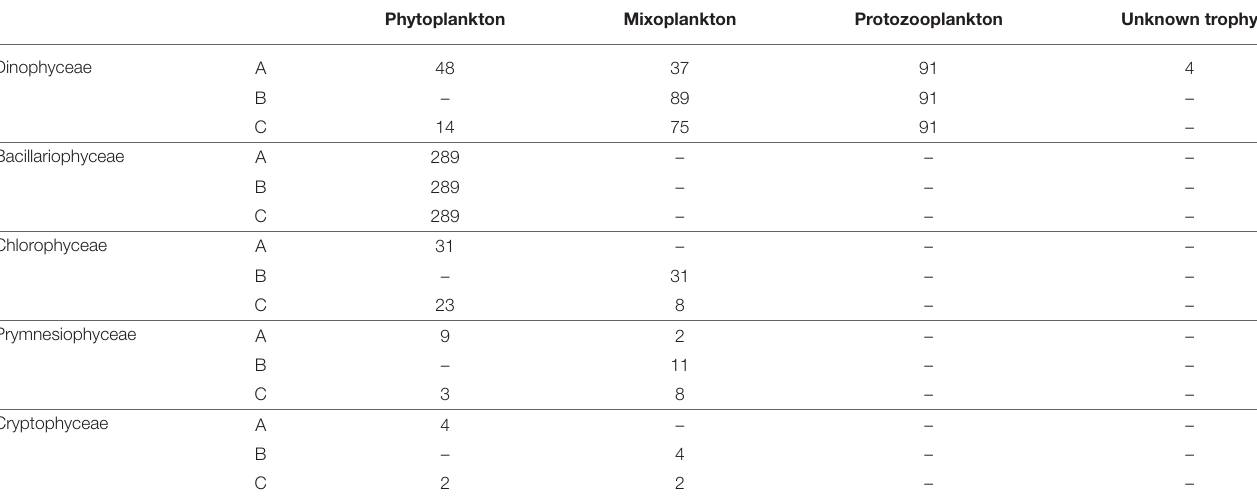
TABLE 2 | Types of trophic mode for the five most important taxonomic classes for each trophic